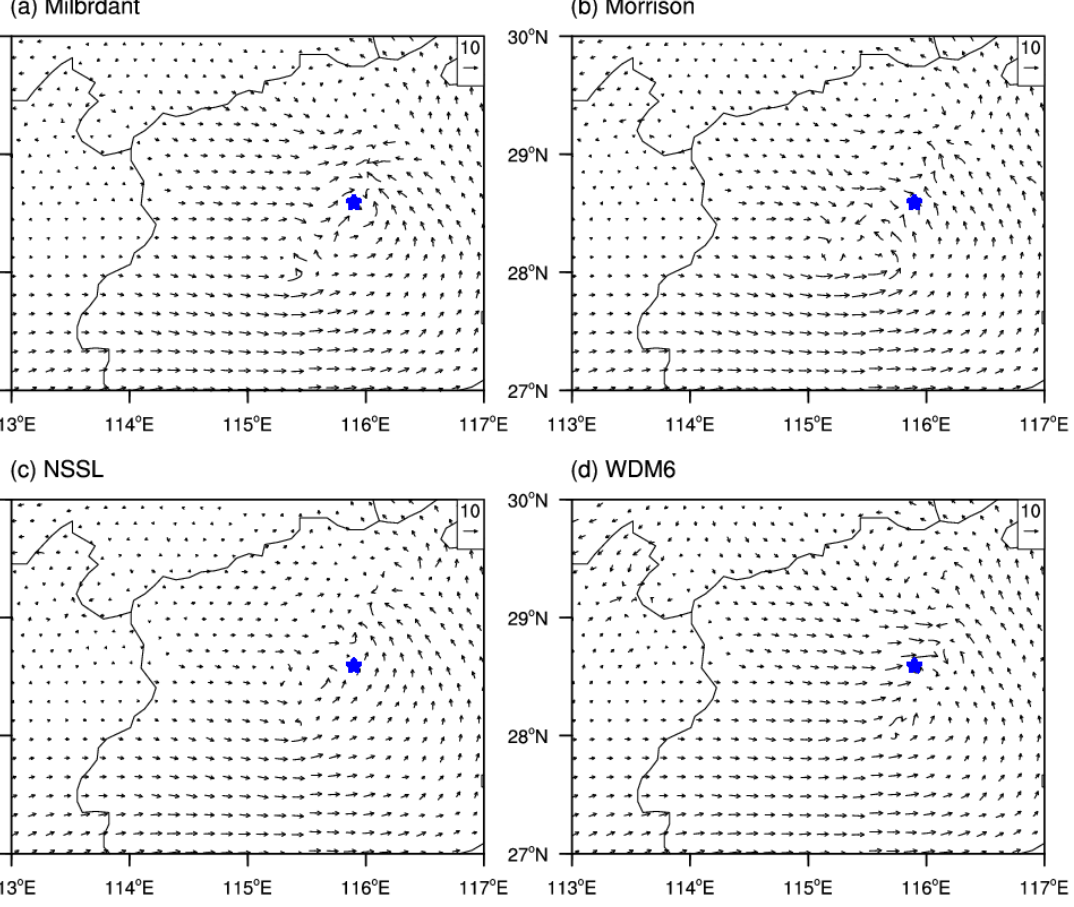
Figure 12. The 700 hPa storm-relative wind fields at 2230 UTC 15 April 2016 simulated by four double−moment MP schemes (vector, units: m·s −1 ). The filled blue star is the location of the Nanchang radar station.The square box in the upper-right corner shows 10 m·s −1 wind.